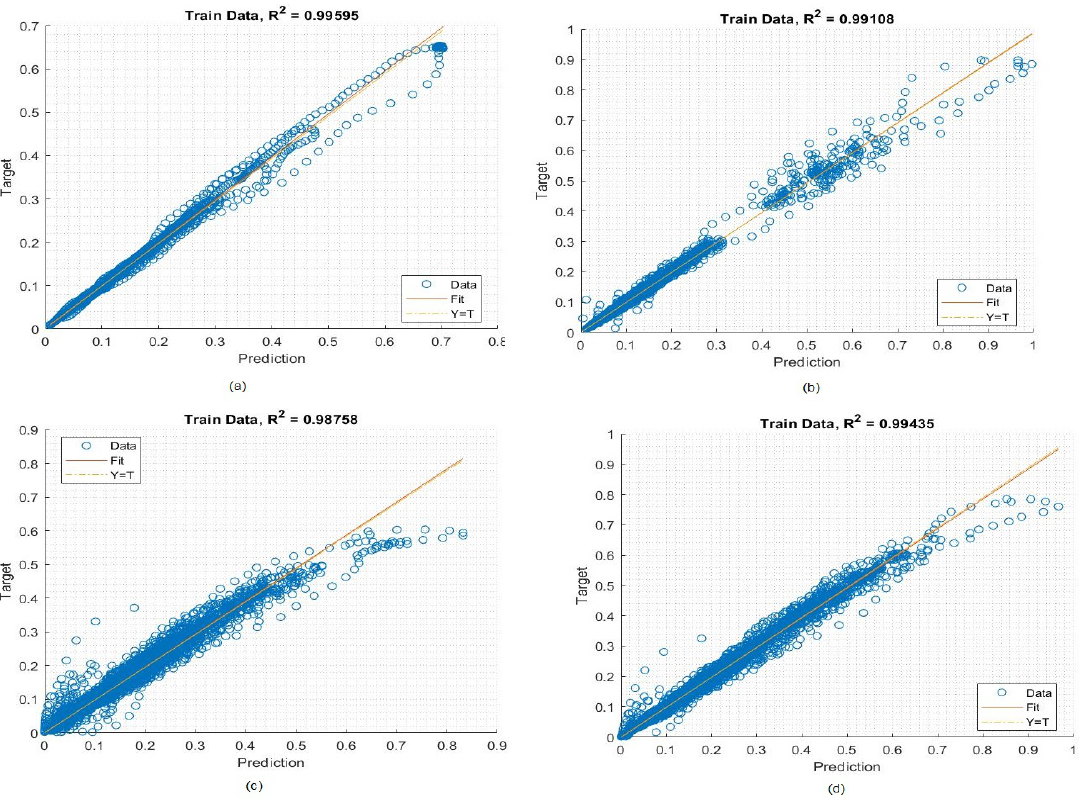
Figure 16. Regression plot of LSTM for predicting stock markets in Saudi Arabia in the training phase, ( a ) communication ( b ) energy, ( c ) financial and ( d ) industrial sectors.